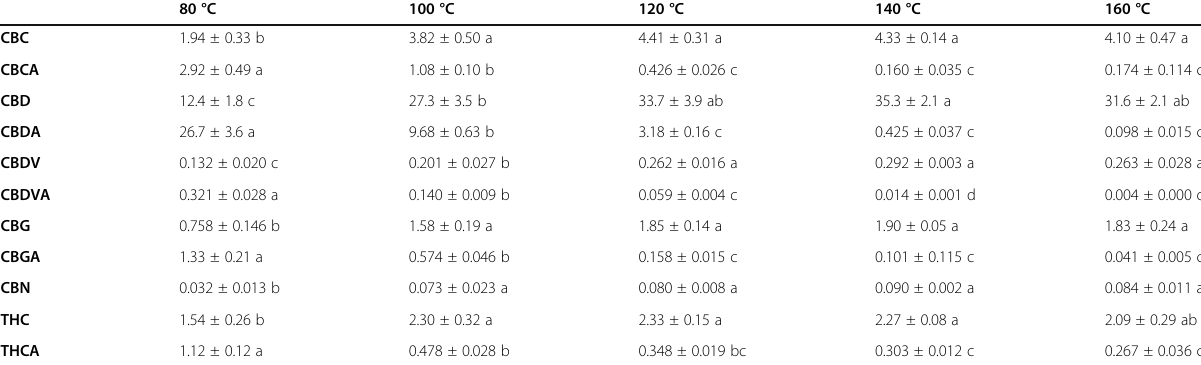
Table 2 Thermo-chemical conversion temperature ’ s impact on cannabinoid extraction content expressed as mg/g hemp